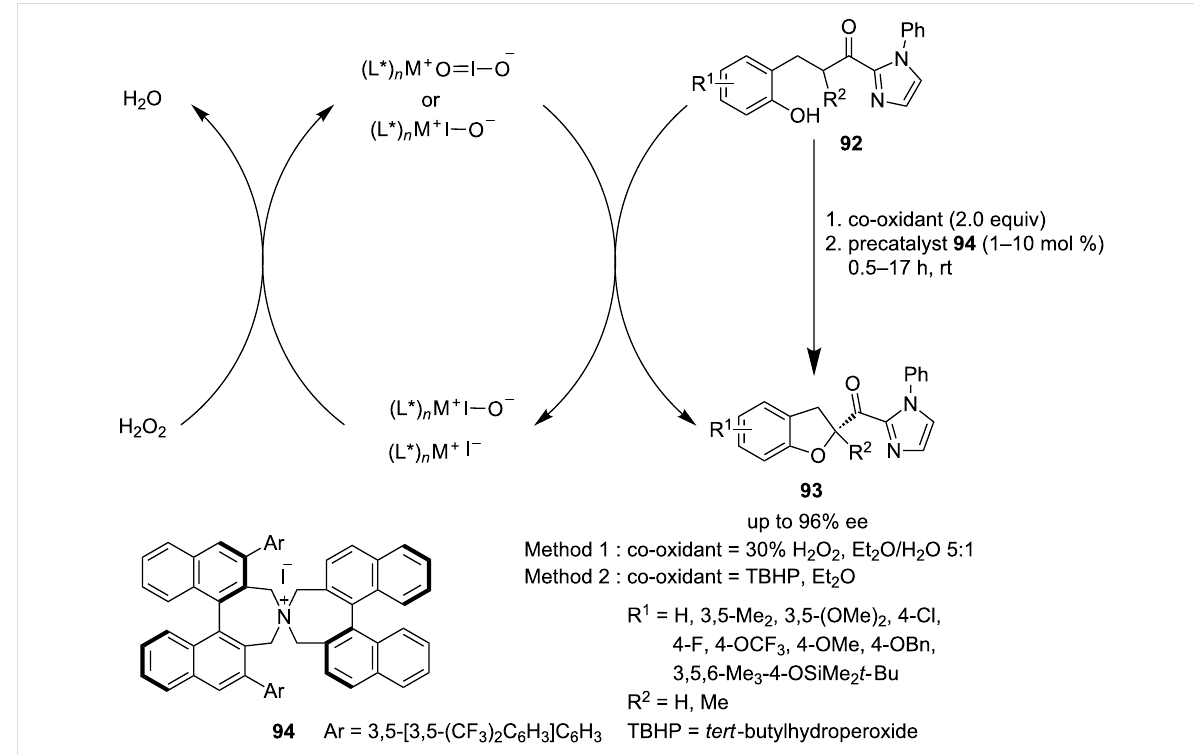
spirooxindoles 96 . Ishihara’s catalyst was modified by using an ( S )-proline derivative to achieve a high level of enantioselectivi- ty in the presence of peracetic acid (Scheme 21) [70].